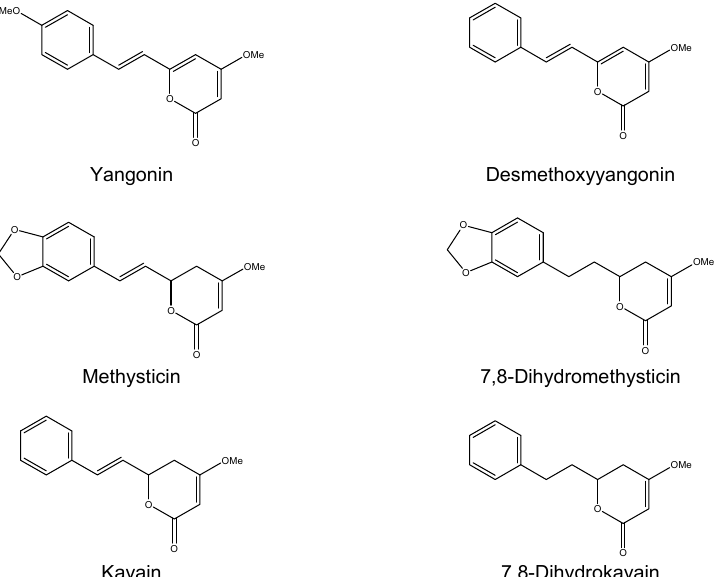
Figure 4. Chemical structures of kavalactones: yangonin, desmethoxyyangonin (DMY), methysticin (M), 7,8-dihydromethysticin (DHM), and kavain, 7,8-dihydrokavain.